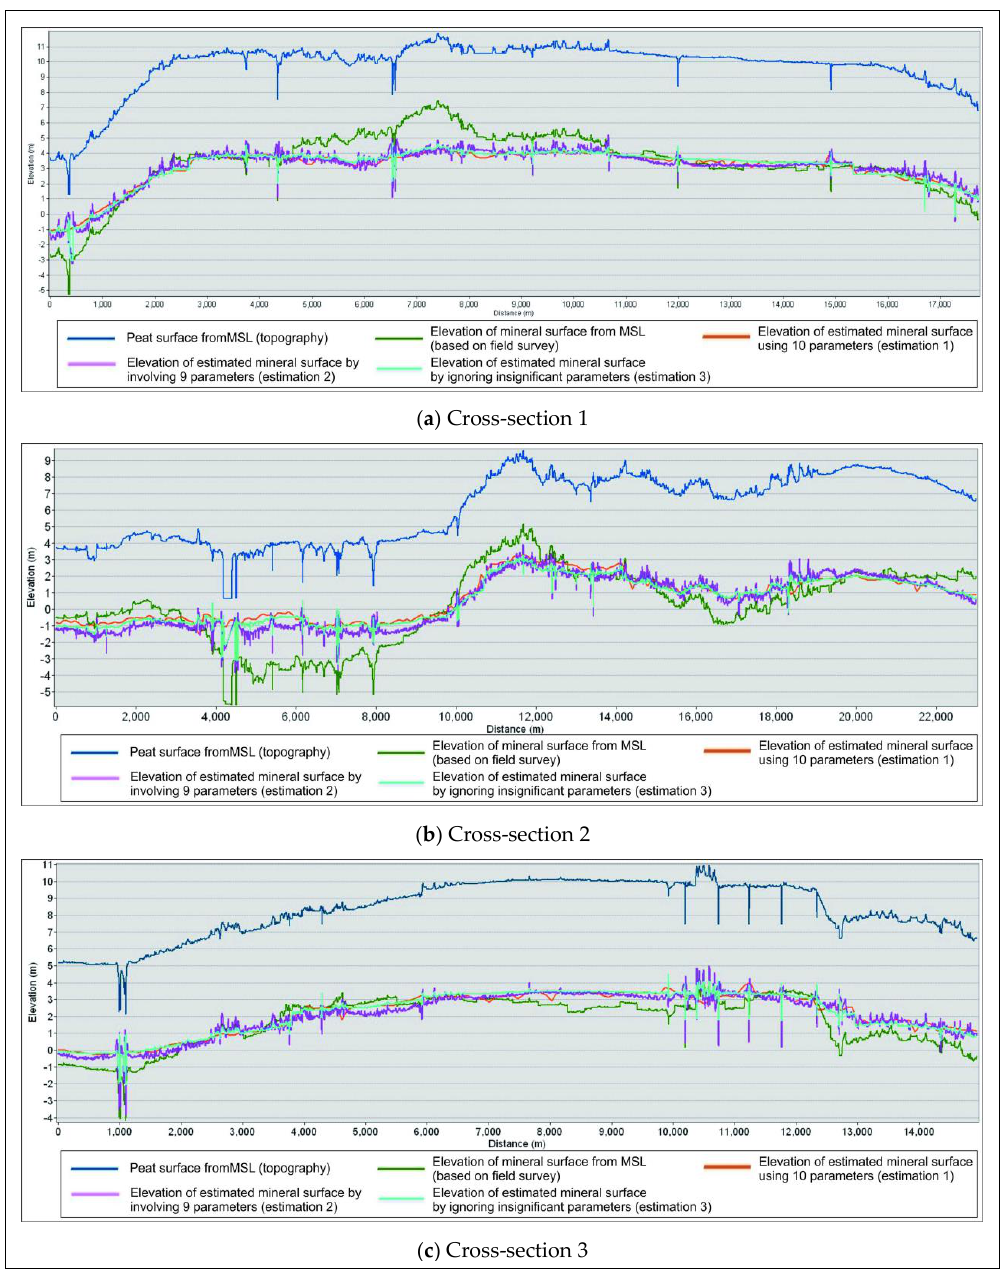
Figure A1. Cross-section view along the lines of Cross-section 1, Cross-section 2, and Cross-section 3 based on estimation 1, estimation 2, and estimation 3 results, which are overlaid on the real mineral soil surface and peat soil surface (topography).